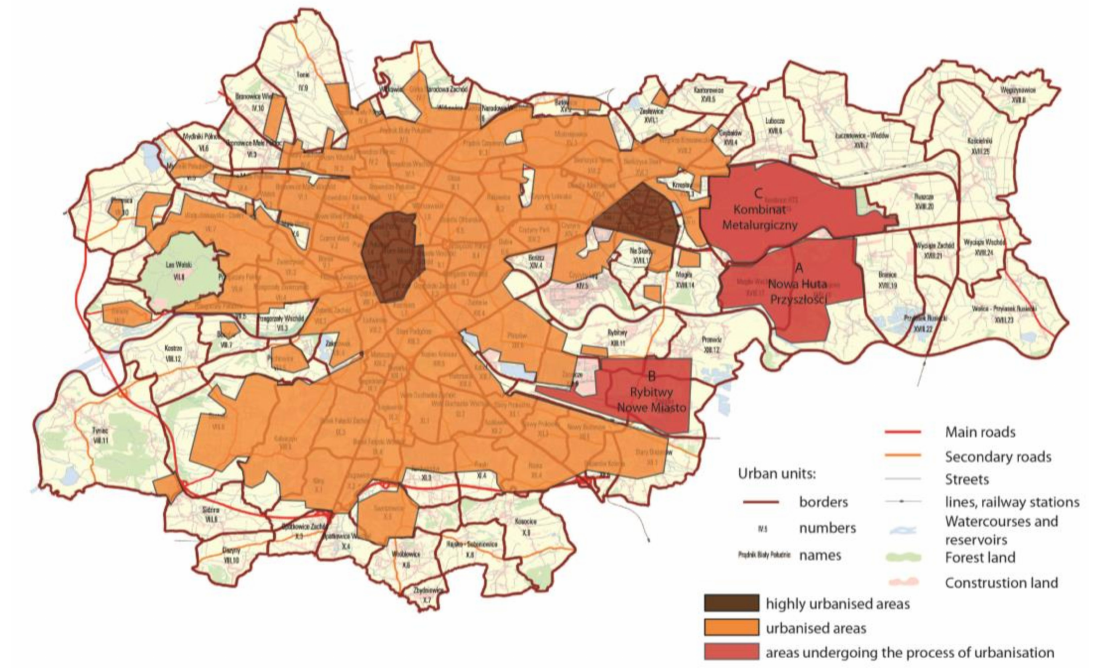
Figure 4. Scheme of highly urbanized areas and the direction of their development. These are the last areas that can become a rainwater management potential. At the same time, they can retain their post-industrial character, pointing to the cultural heritage of this area and the rich multicultural history of the industry in Cracow. It is possible to link post-industrial structures with a simultaneous ecological function, especially